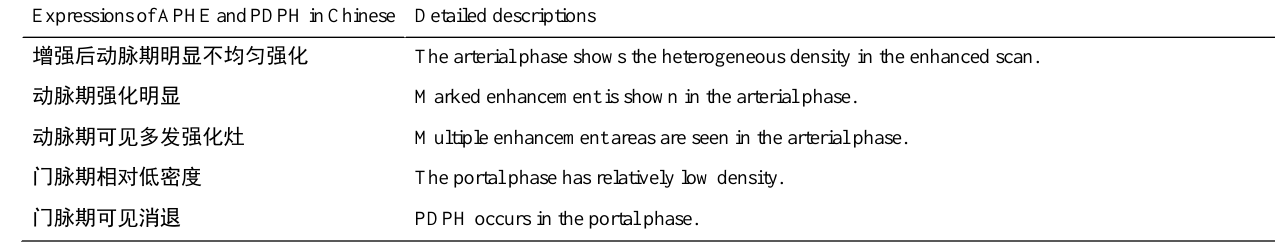
Table 1. Some expressions of APHE a and PDPH b in Chinese.